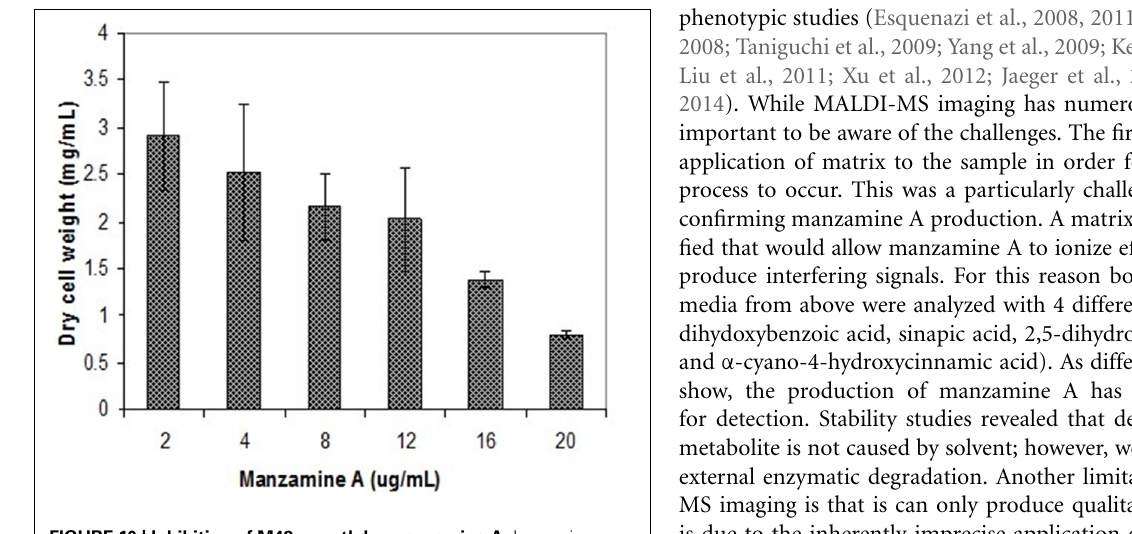
FIGURE 10 | Inhibition of M42 growth by manzamine A. Increasing manzamine A concentration inhibits the growth of M42 in a dose dependent fashion. The error bars represent the range of the positive and negative standard